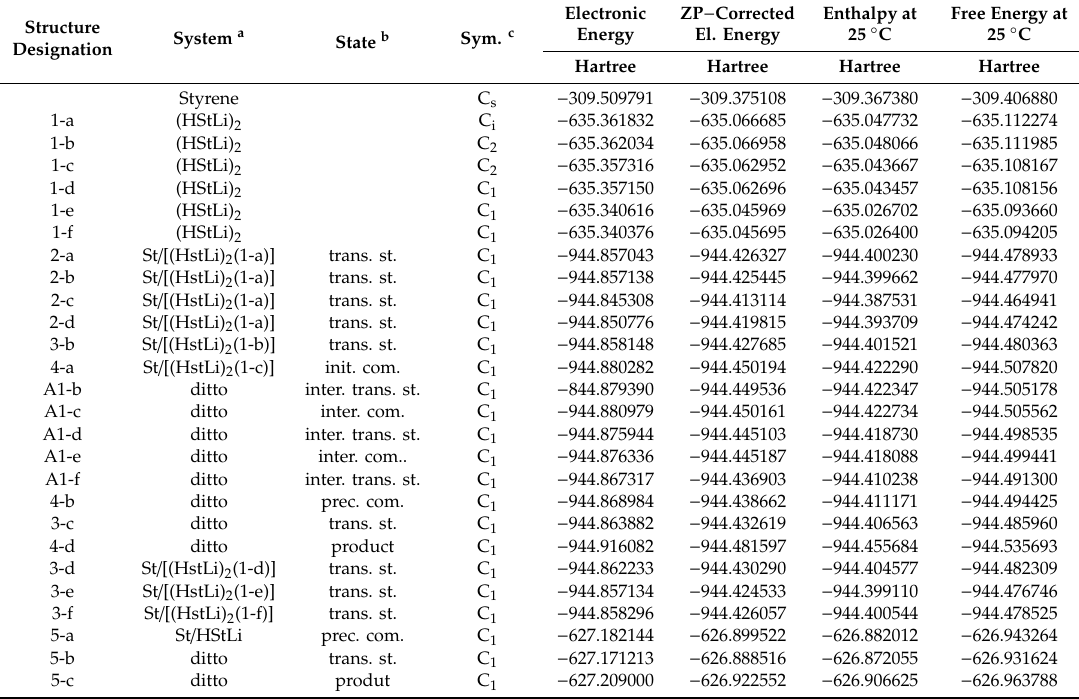
Table A1. Calculated electronic energies, zero-point(ZP)-corrected electronic energies, enthalpies (H) and Gibbs free energies (G) at 25 ◦ C in the gas phase for dimeric (HStLi) 2 , intermediates and products of their reaction with styrene, and intermediates and products of the reaction of non-associated HStLi with styrene.